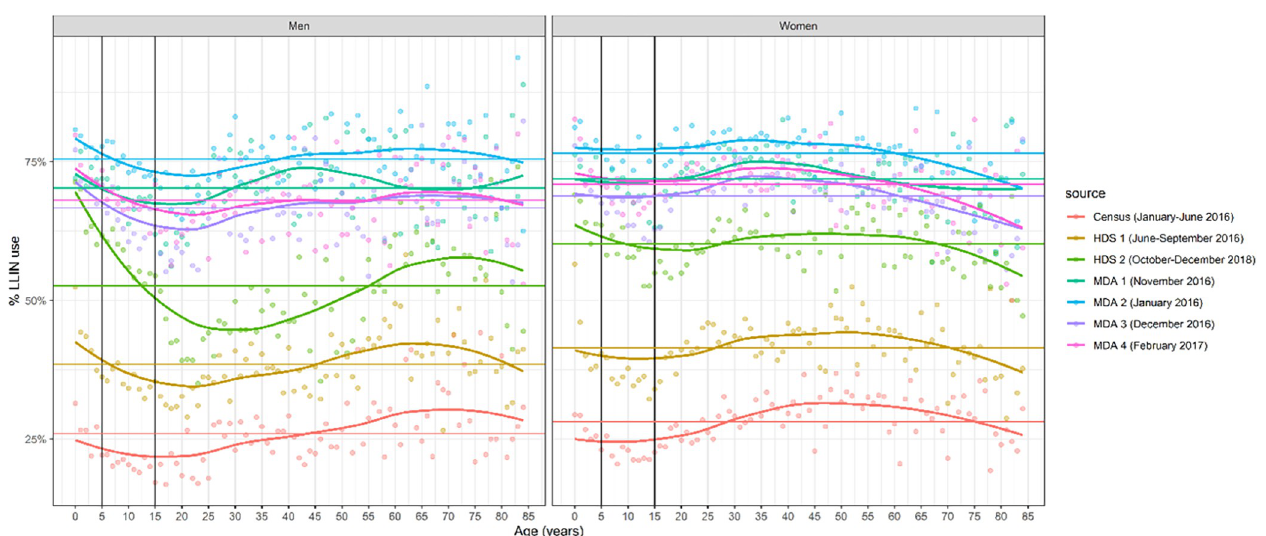
Fig 3. LLIN use across age and gender in Magude district during the project. Each line represents data from a single survey or study conducted during the Magude project. Each point is the average bednet use found for the corresponding age in the corresponding study. MDA estimates represent between 77.7% and 89.6% of the population, depending on the MDA